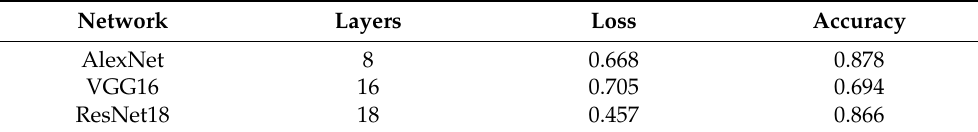
Table 3. Performance comparison between AlexNet, VGG16, and ResNet18.